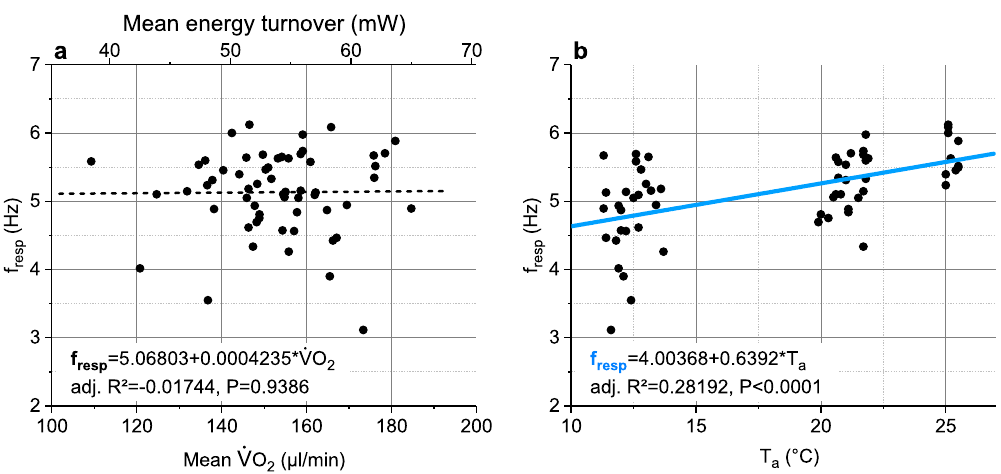
Figure 5. Dependence of stationary honeybee forager respiratory frequency (f resp ) on ( a ) oxygen turnover (VO 2 ), and ( b ) ambient air temperature (T a ). Bees gathered 0.5 M or 1.5 M sucrose solution in unlimited flow. R 2 = adjusted for degrees of